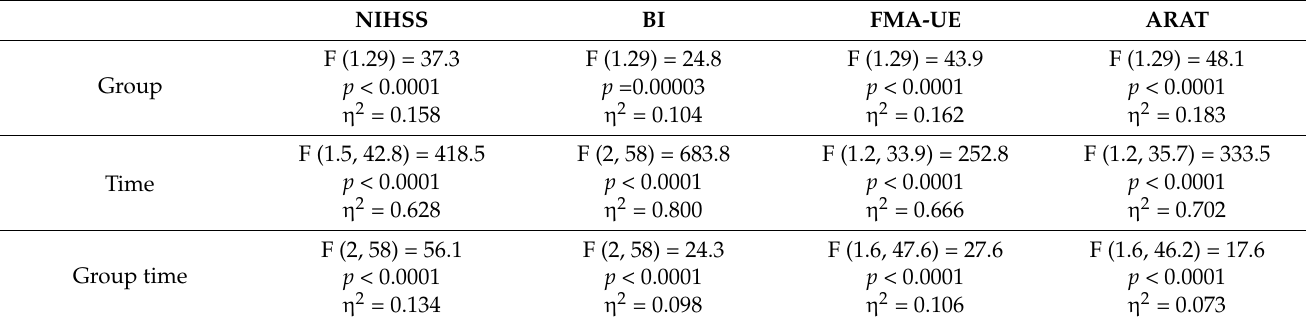
Table 2. The changes in the outcome measures over time.